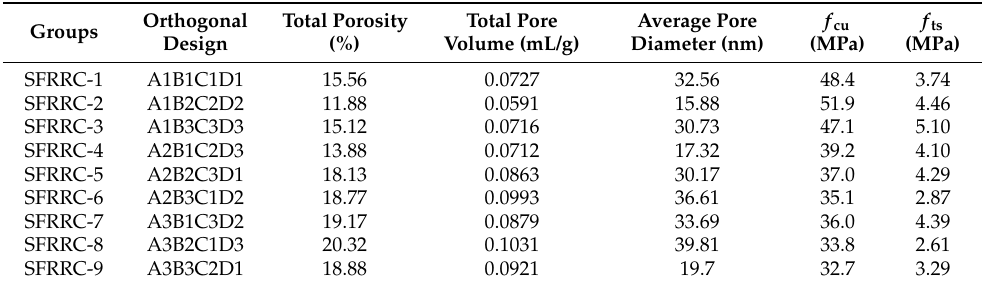
Table 8. Pore characteristic parameters and strength of SFRRCs.